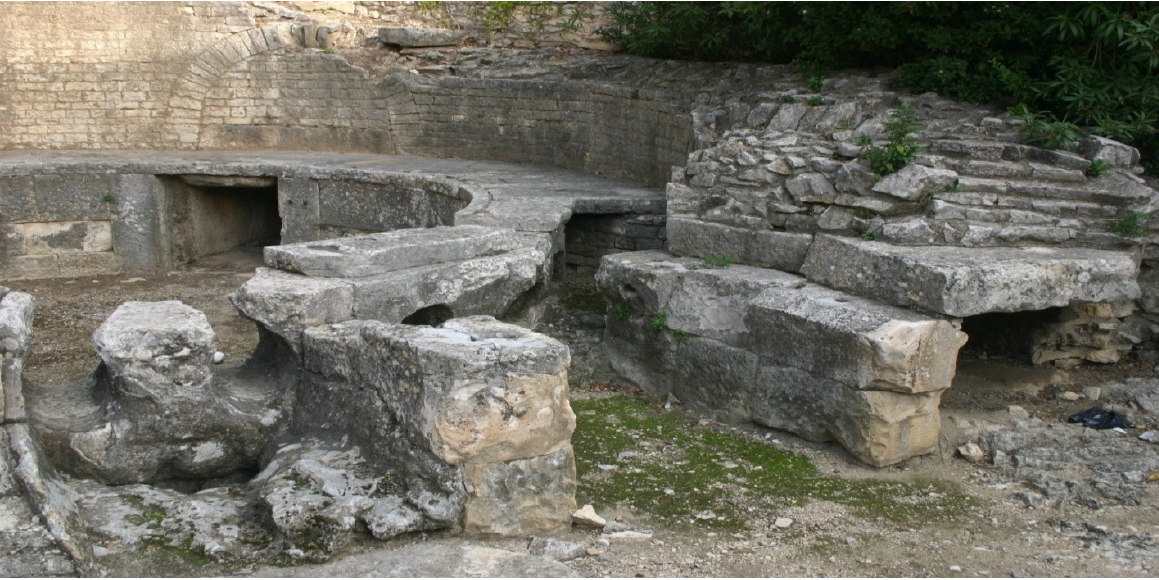
Figure 4. View of the front of the Nîmes castellum .